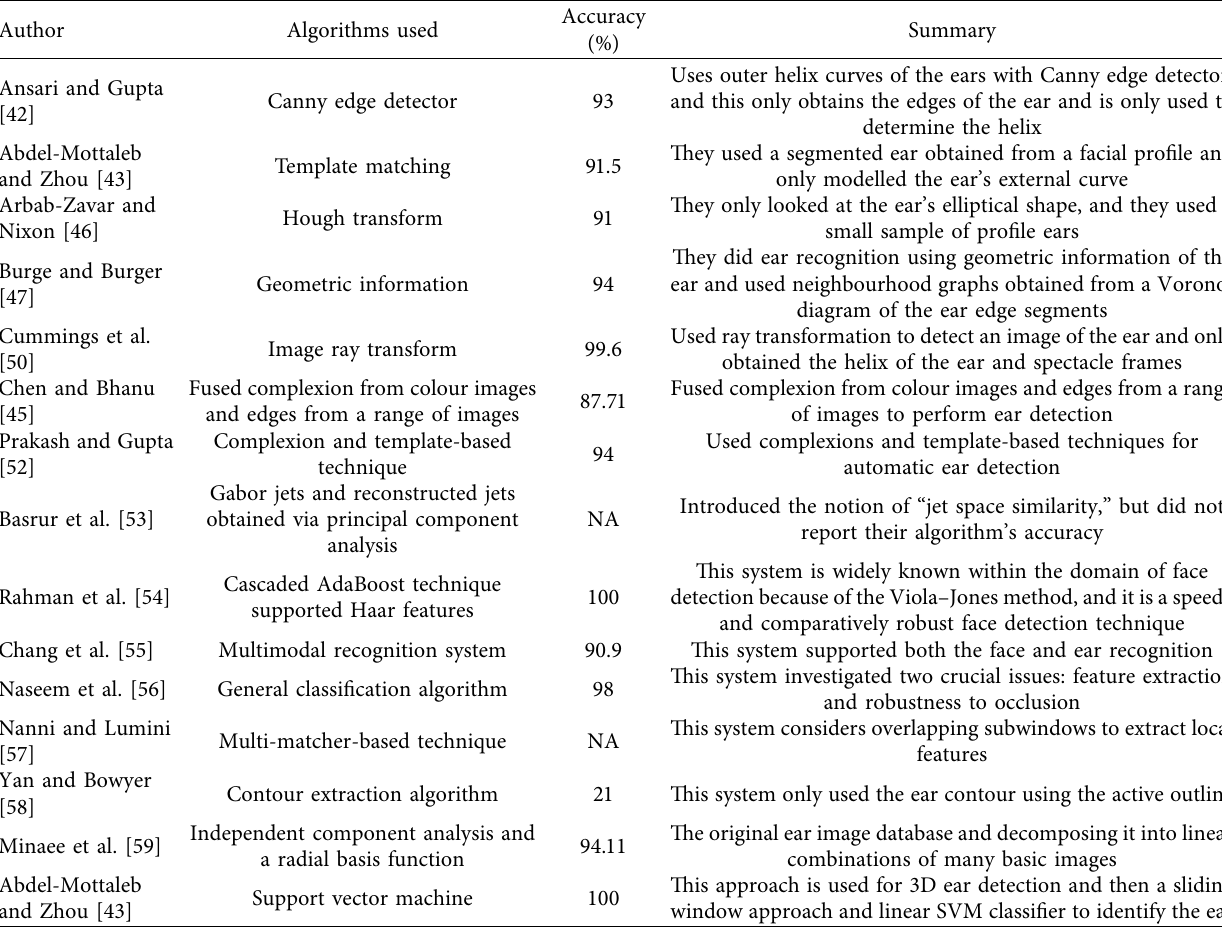
Table 4: Summary of the ear